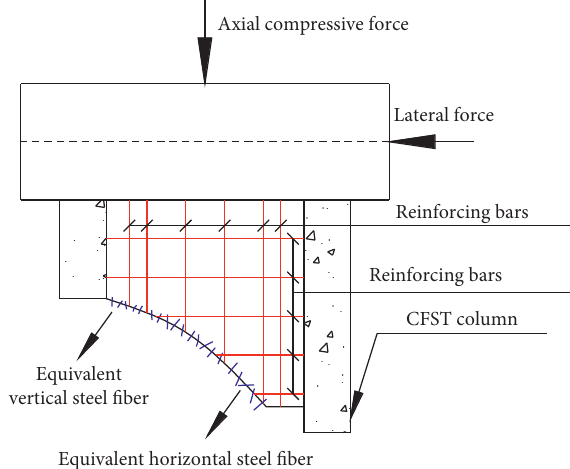
Figure 7: Steel fiber